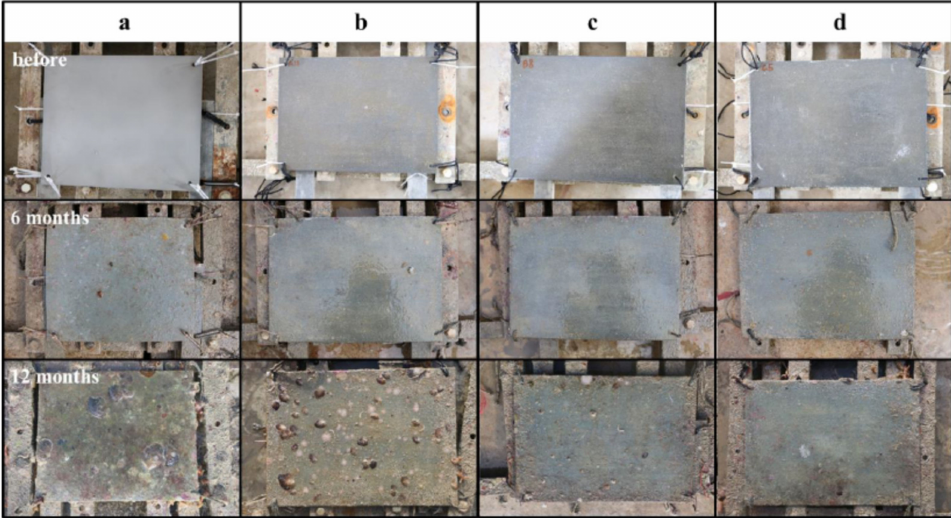
Figure 14. Photographs of the flat panels: ( a ) uncoated; ( b ) coated with epoxy resin directly doped with 5 wt.% DCOIT; ( c ) halloysite epoxy resin composites with 5 wt.% DCOIT plus 2 wt.% loaded in nanotubes; and ( d ) plus 5 wt.% loaded in nanotubes. Upper images—before; and lower images—after shallow submergence in Sanya Bay, South China Sea, March 2018–February 2019. Figure derived from the work of Fu et al.